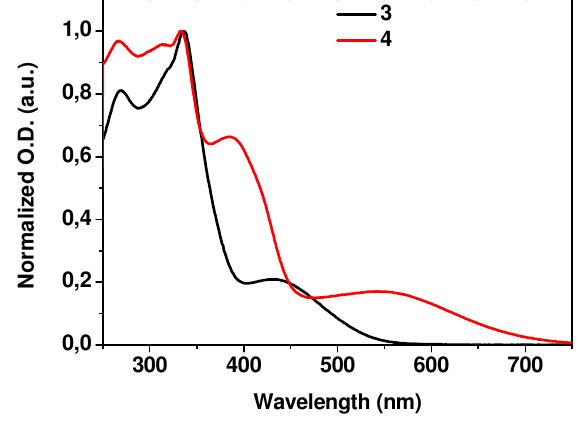
Figure 6. Electronic absorption spectra of the pincer 3 and the zinc complex 4